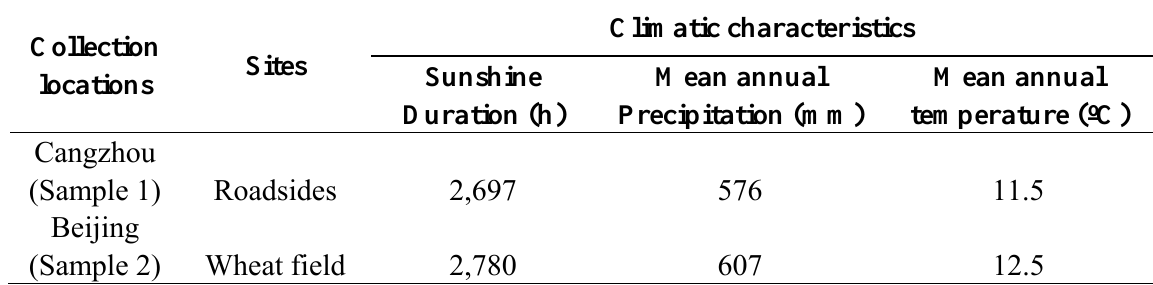
Table 2. Geographic and climatic characteristics of collection